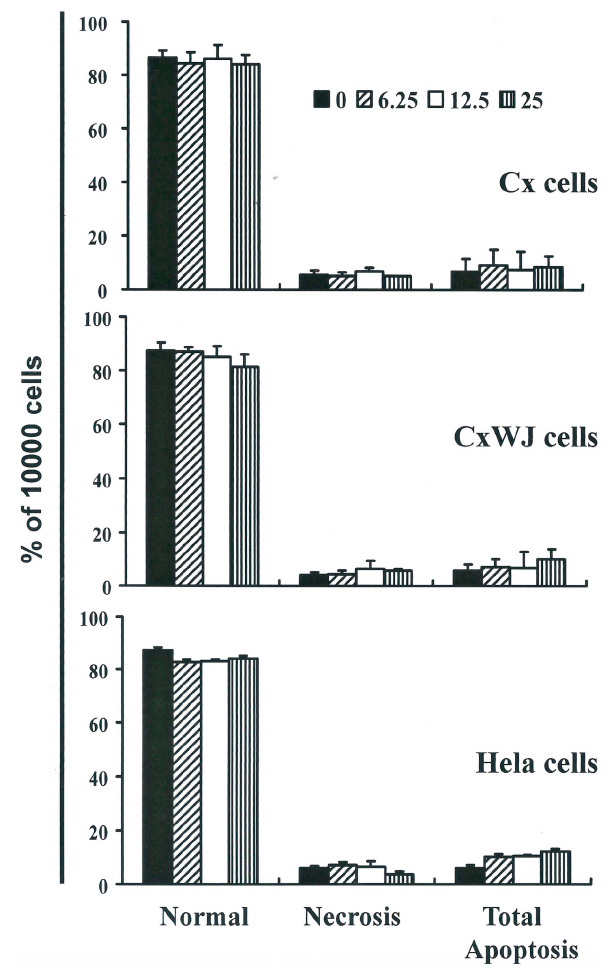
Figure 2. Total apoptosis and necrosis in cervical cancer cell lines after 4 h of incubation with SFN (0, 6.25, 12.5, and 25 μ M). Results are expressed as a percentage of control group cells, necrosis, and total number of apoptotic cells (including both early and late apoptosis).